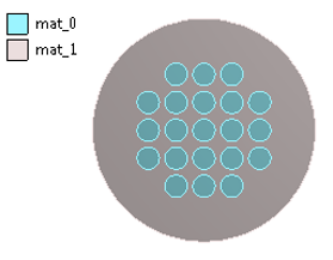
Fig. 6. A geometric model of a representative volume of material with a regularly heterogeneous